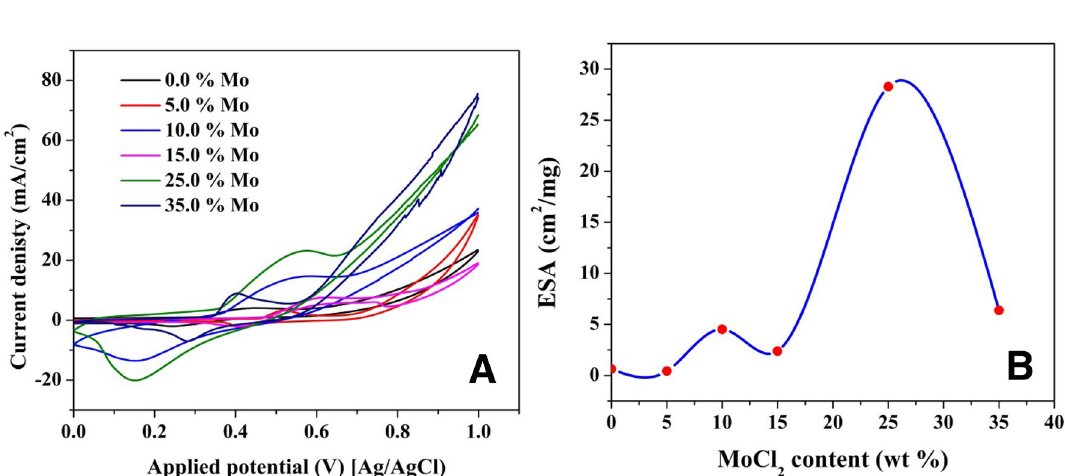
Figure 7. Activation of Mo 2 C/Ni-incorporated carbon nanofibers with different Mo content and prepared at 850 °C ( A ), and influence of the Mo content on the electrochemical surface area ( B